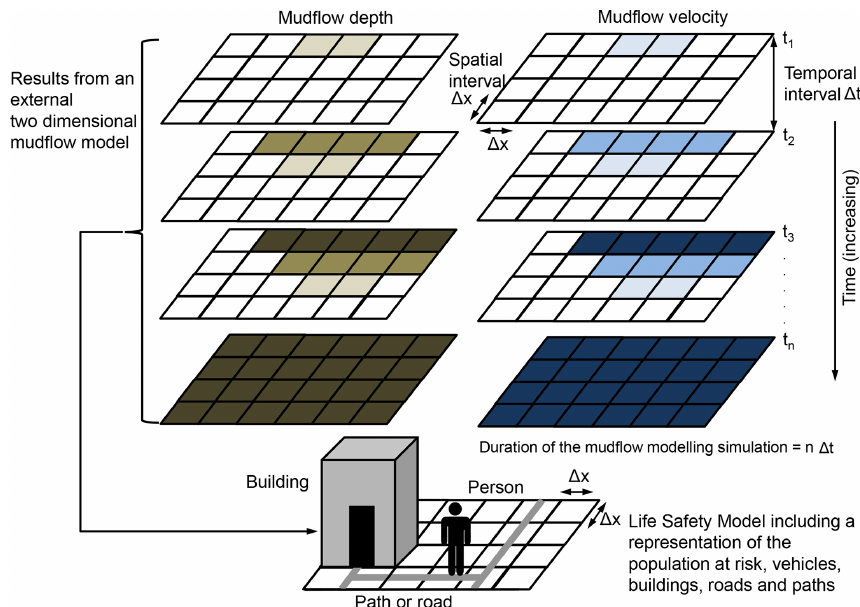
Figure 9. Schematic diagram showing how results from a two-dimensional fully hydrodynamic mudflow model are linked to the LSM.